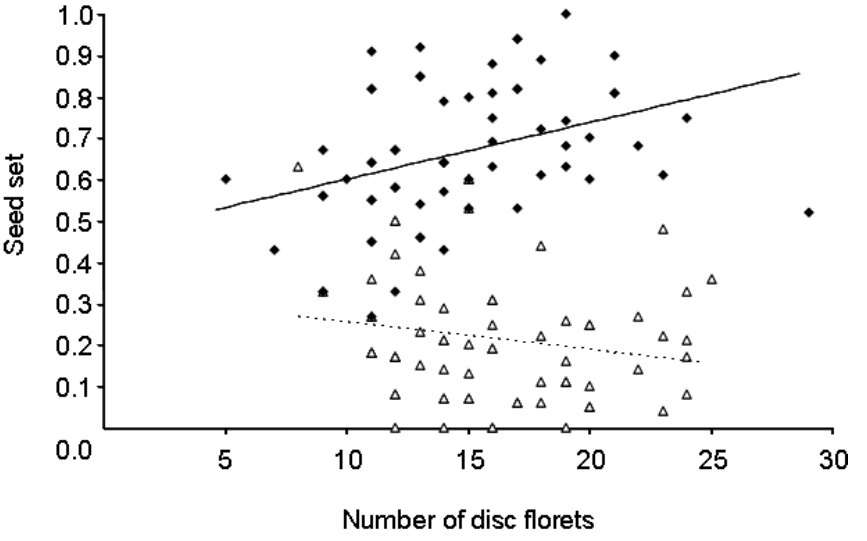
F IGURE 2. Correlation